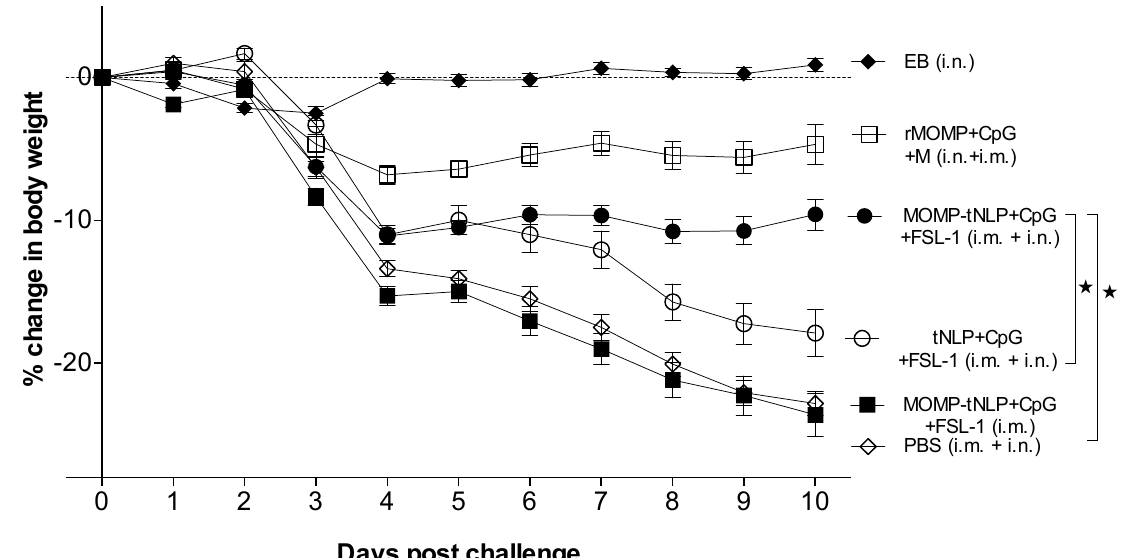
Figure 4. Daily percentage change in mean body weight following the i.n. challenge. * p < 0.05 by the Repeated Measures 2-way ANOVA.